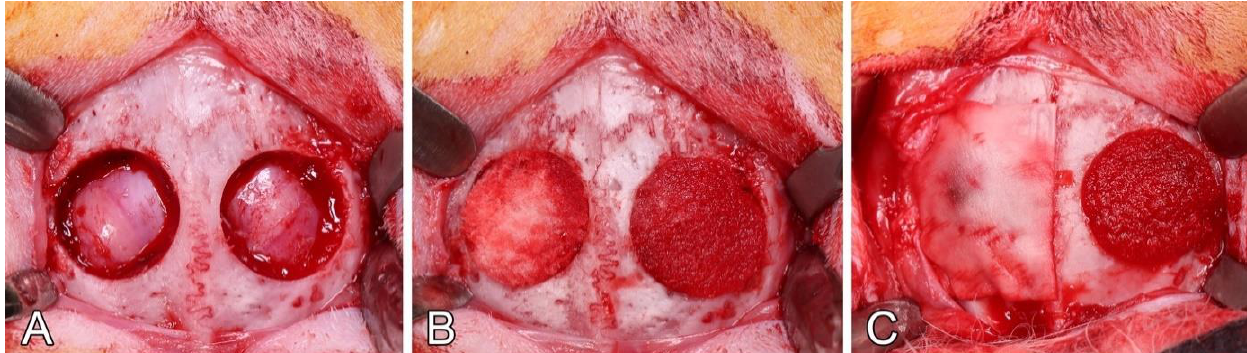
Figure 3. Intrasurgical view of the exposed rabbit calvaria. ( A ); Two 10mm diameter defects were created in the parietal bone with a trephine drill. ( B ); Allocated materials were implanted in the defects: left defect, CM; right defect, mCM. ( C ); Left defect is covered with a collagen barrier membrane (12 × 12.5mm).